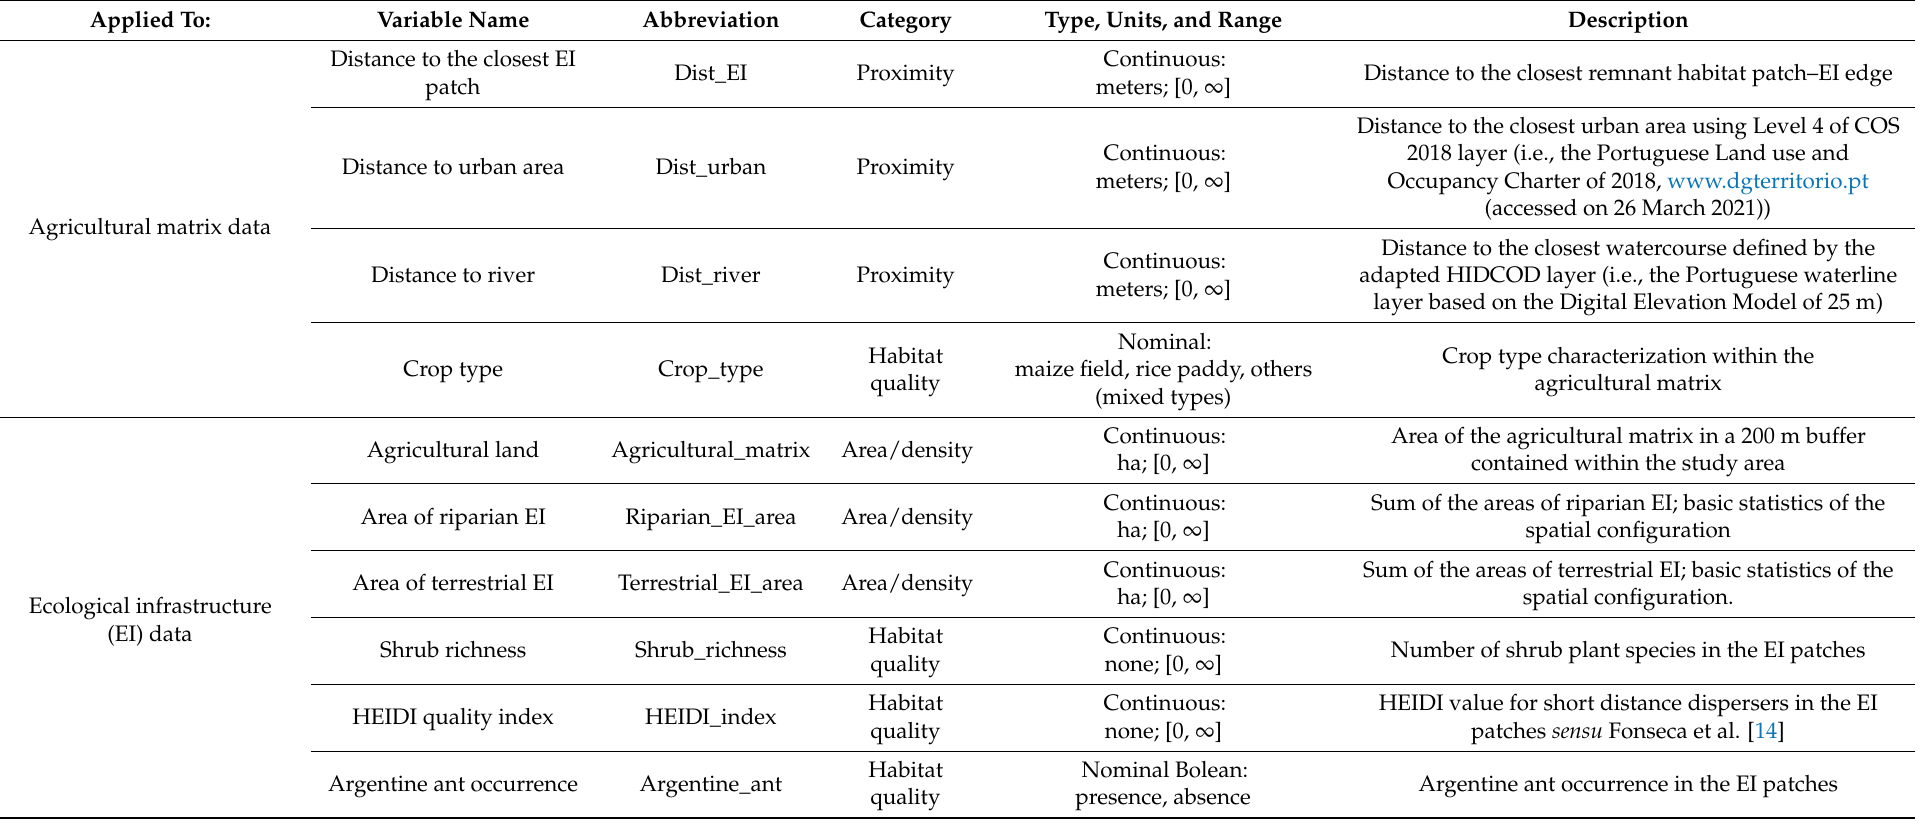
Table 1. Description of the variables used in the